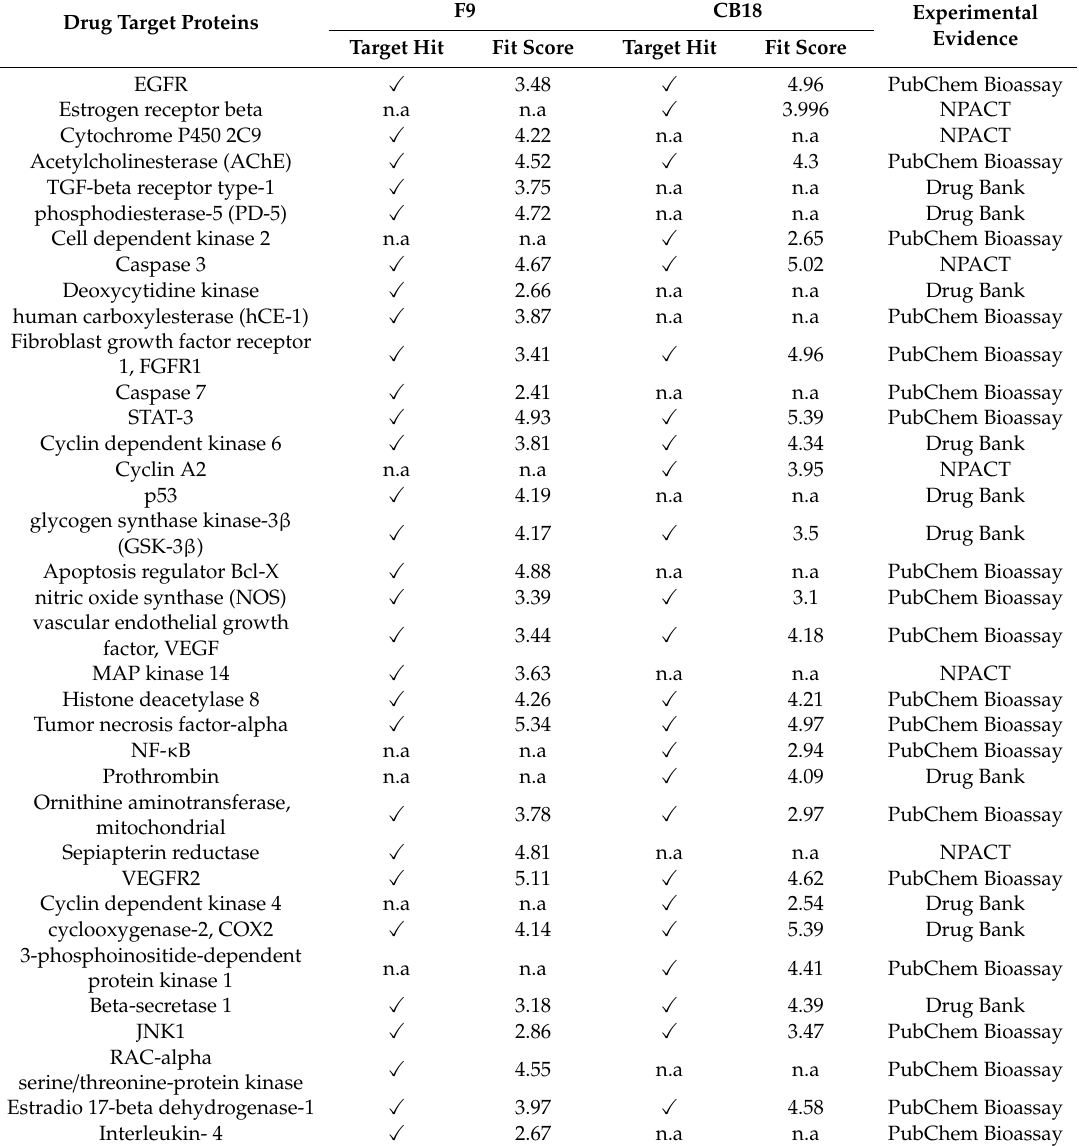
Table 1. Potential therapeutic targets of isolates F9 and CB18 identified by PharmMapper and